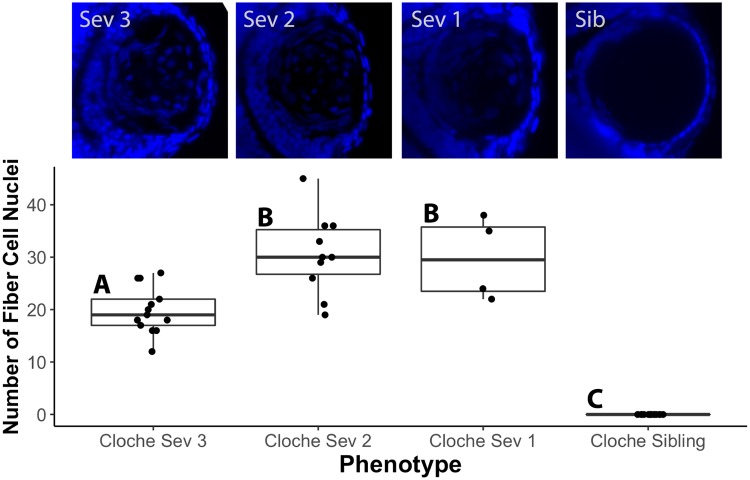
Quantification of retained fiber cell nuclei in cloche lenses of different phenotype severity compared to non-phenotype siblings by DAPI staining.Images above the graph show representative lenses for each severity type at 4 dpf. Fiber cell nuclei were significantly more abundant in all cloche lenses compared to siblings. Within cloche embryos, severity type 3 lenses (the most severe) contained fewer nuclei than severity type 2 or 1 (ANOVA p value < 0.0001; letters indicate statistical groups determined by Tukey Honest Significant Difference (HSD) post test).